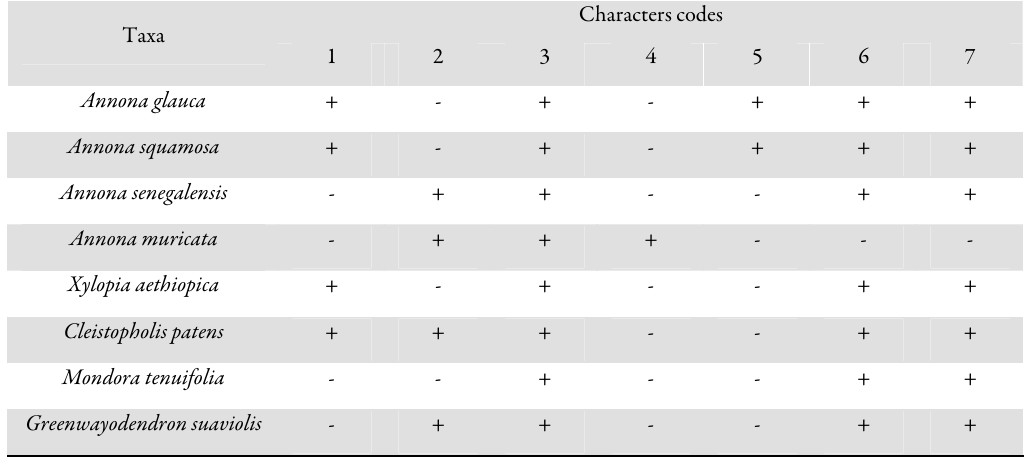
Tab. 2. Comparison of some qualitative anatomical feature of some Annonaceae